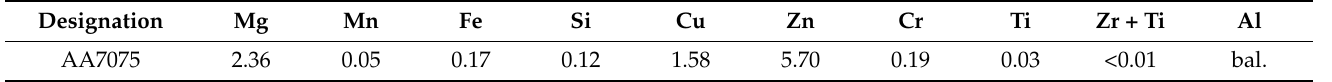
Table 1. Chemical composition of the selected aluminium alloy